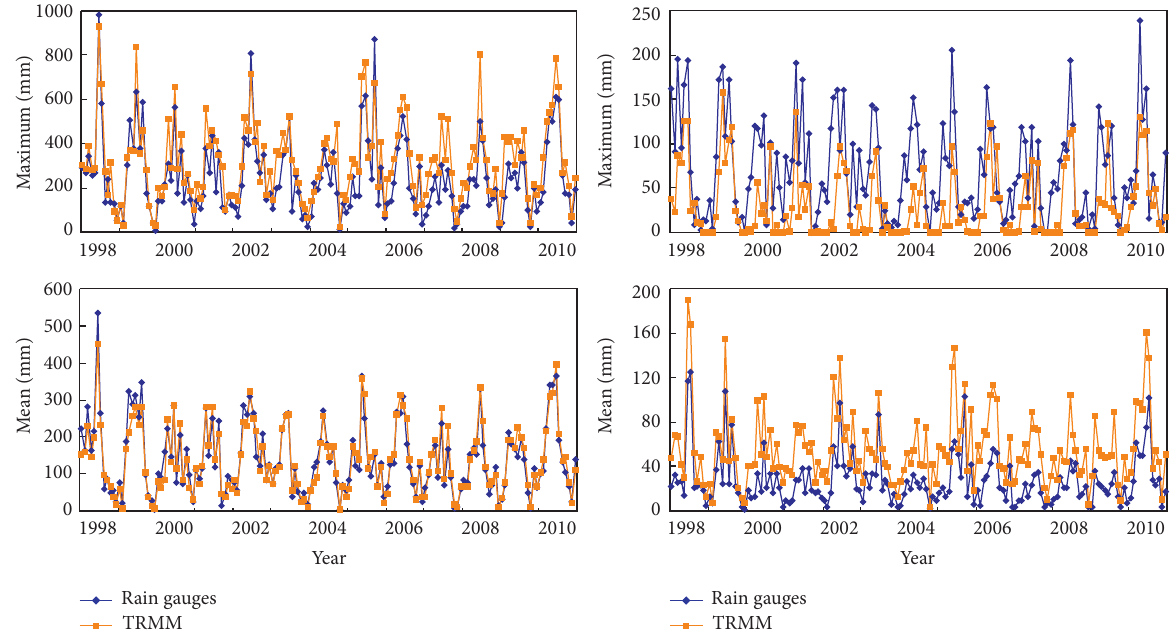
Figure 6: Comparison of maximum, minimum, mean and standard deviation between TRMM and interpolated gauges rainfall. Table 2: Comparison of statistical indices between short and long period data series.